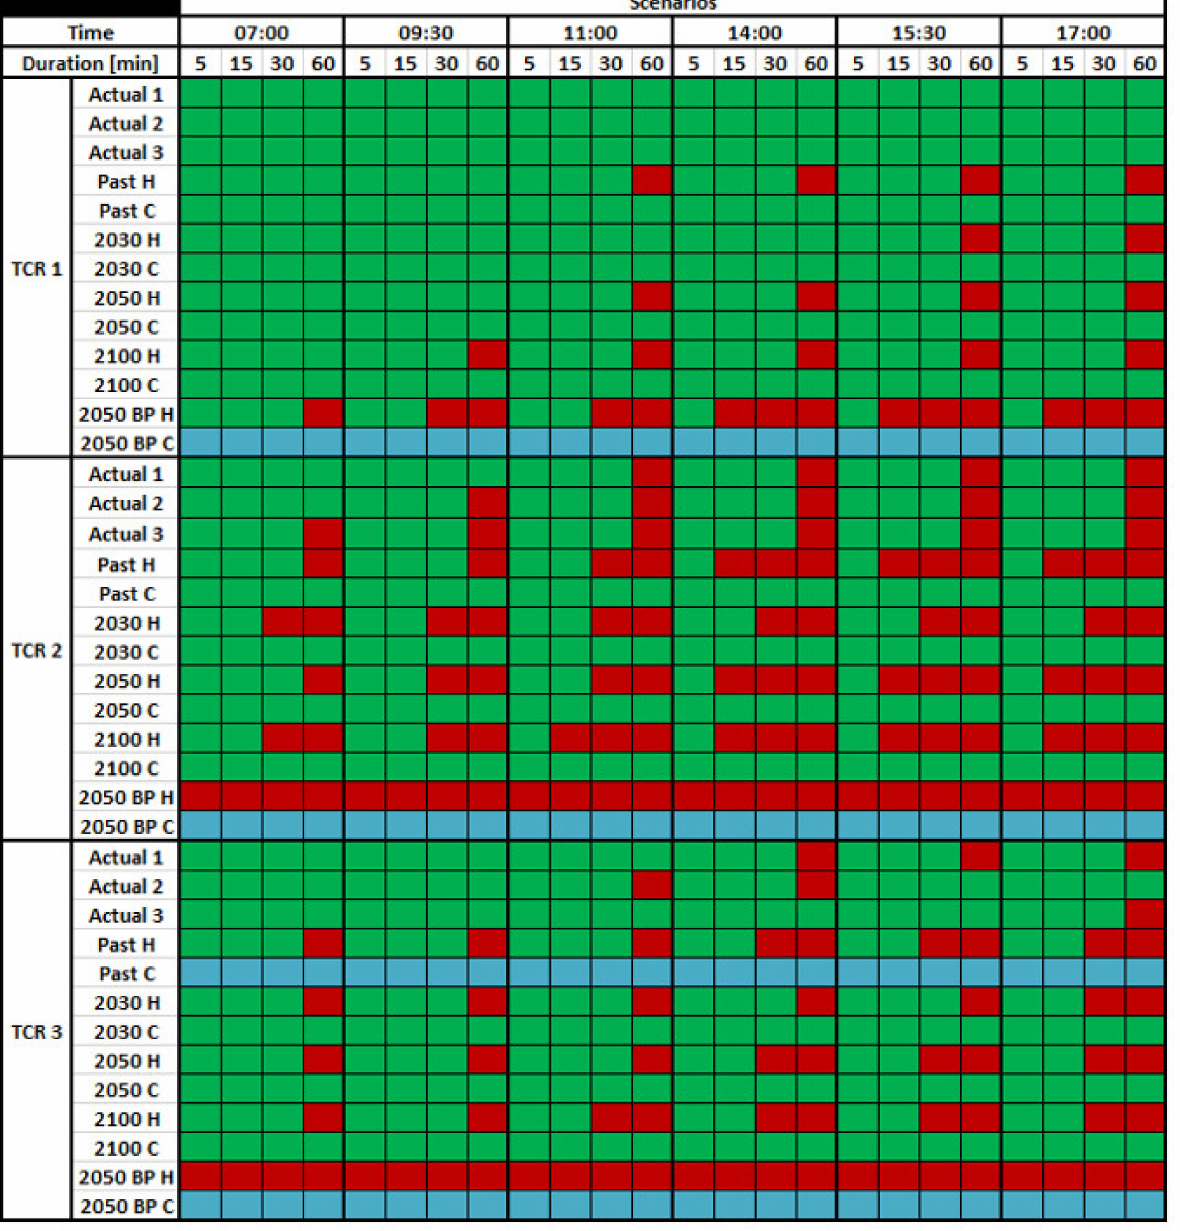
Figure 8. Overview of all scenarios, categorized by no risk (green), overheating risk (red) and overcooling risk